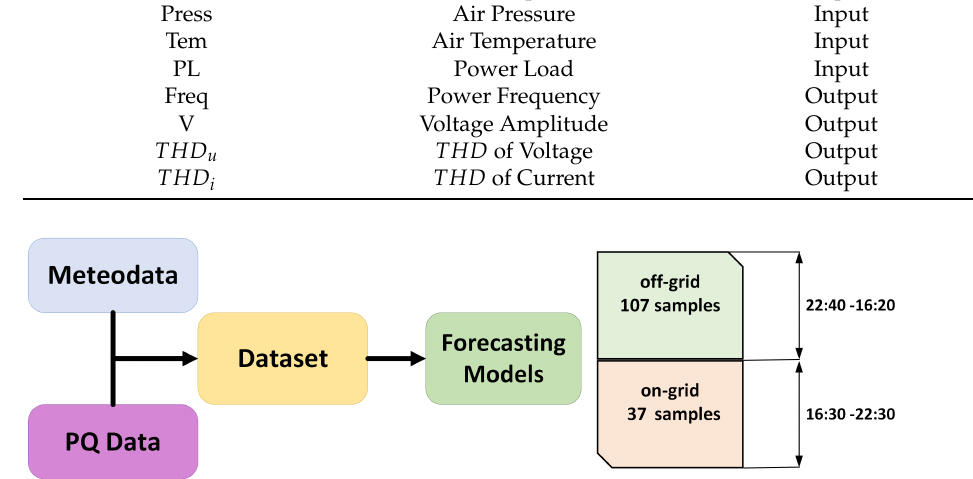
Figure 3. Structure of training and testing dataset.